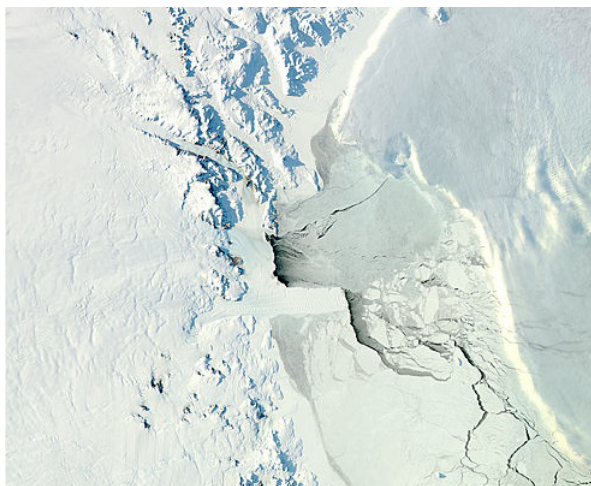
Figure 1. One kilometer Aqua True Color satellite image from 24 September 2009. The Drygalski Ice Tongue, located in the cen- ter of the image, extends approximately 50km from the coastal edge into the sea. North is at the top of the image. Data collected from the website of the National Aeronautics and Space Admin- istration (NASA) at http: // lance-modis.eosdis.nasa.gov / imagery / subsets / ?mosaic = Antarctica.